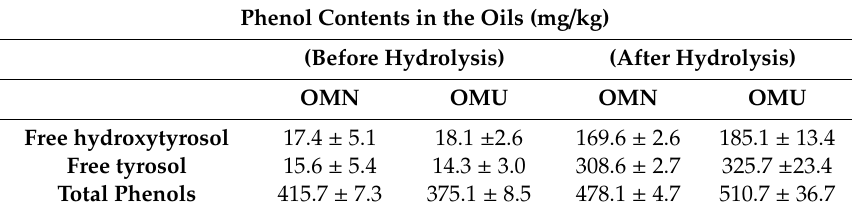
Table 2. Phenol contents determined before and after acidic hydrolysis. Results are expressed as mean ± s.d. of analysis of three extracts of the same samples. ± s.d. of analysis of three extracts of the same samples.